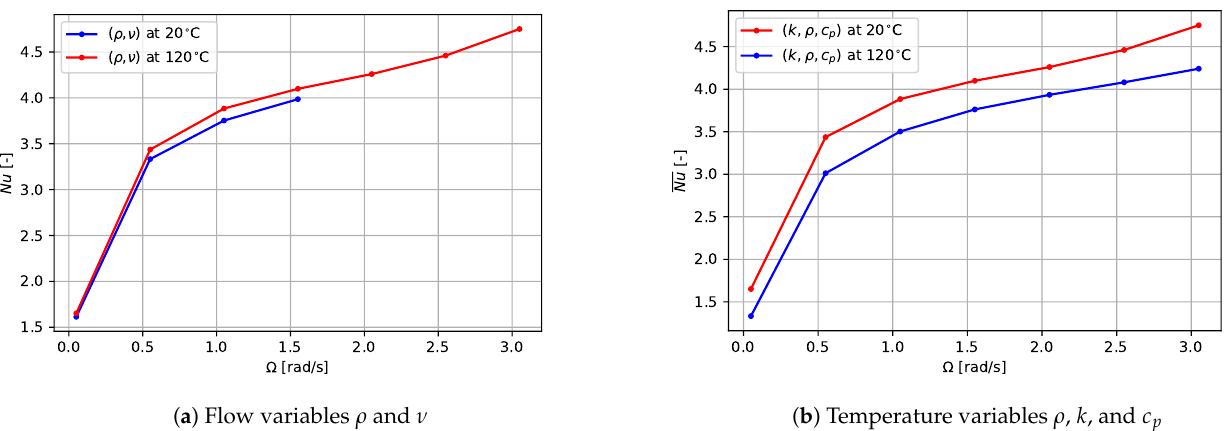
Figure A1. Effect of varying flow and temperature fluid properties, i.e., the density ρ , the viscosity ν , the conductivity k and the specific heat capacity c p , on the average Nusselt number at the core